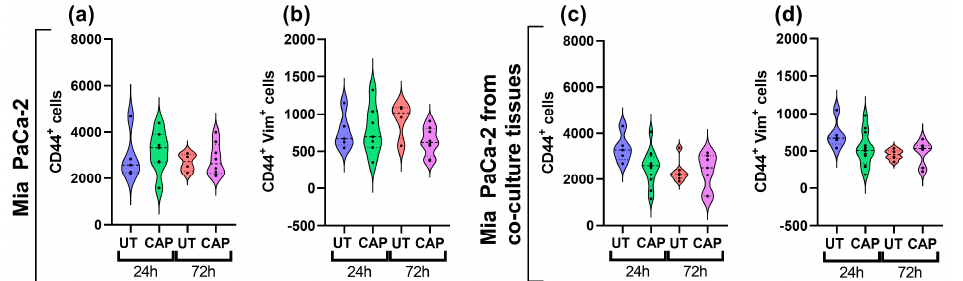
Figure 7. Vimentin expression in Mia PaCa-2 of single and co-cultured in ovo tissue. Tissue sections were stained for CD44 and vimentin. Number of cells positive for ( a , c ) CD44, ( b , d ) CD44 and vimentin. UT = untreated control. n ≥ 4 tissue per condition. Each dot represents one tissue. Dashed lines = median; dotted lines = 25% and 75% quartiles.